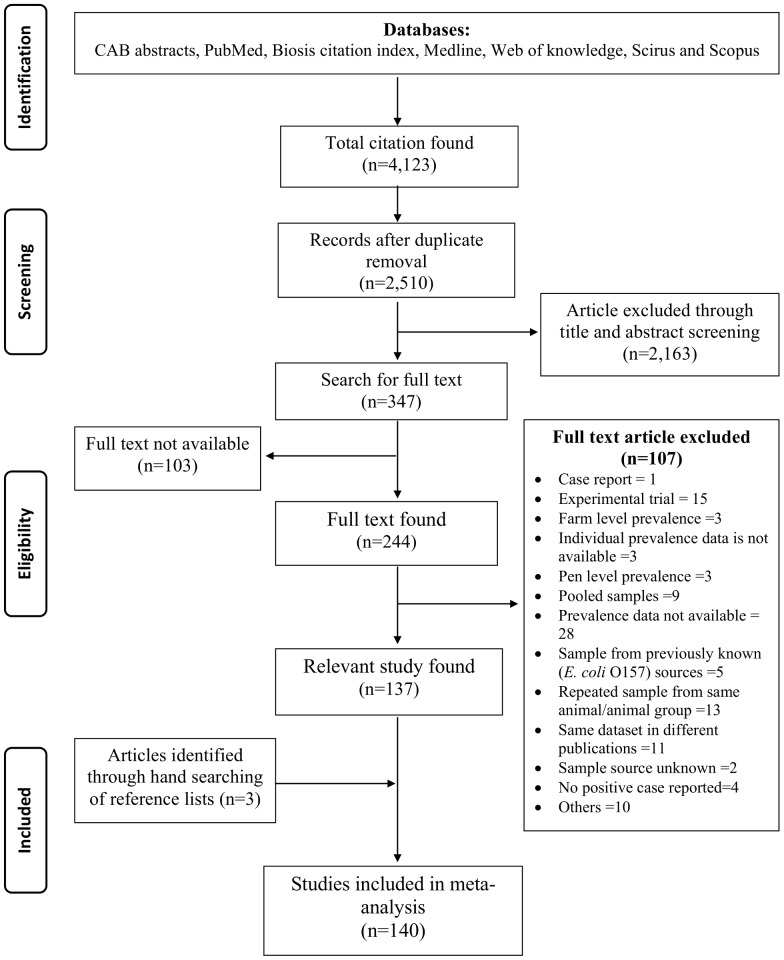
Flow diagram of study selection for inclusion in the meta-analysis.